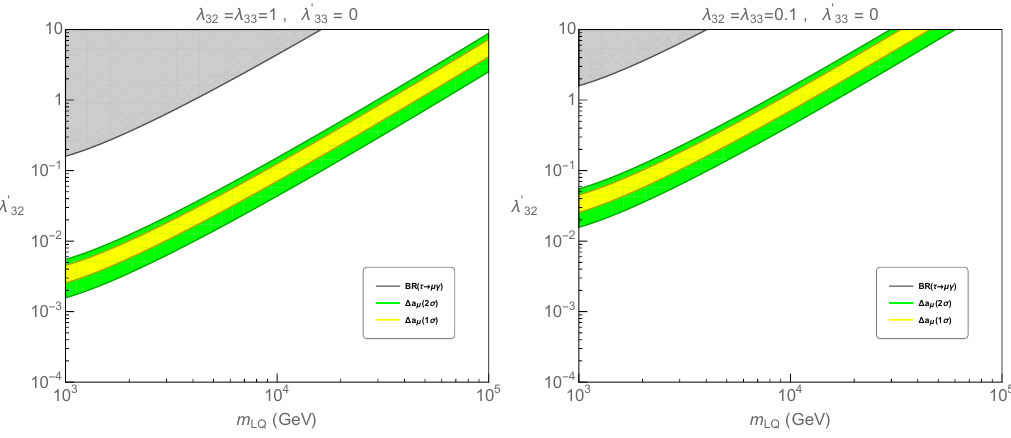
Figure 2 . Parameter space for m LQ = m S at 2 (cid:27) (1 (cid:27) ) level. The gray region is excluded by the bound on BR( (cid:28) ! (cid:22)(cid:13) ). We have (cid:12)xed (cid:21) 32 = (cid:21) 33 = 1(0 : 1) on left(right) plot and (cid:21) 0 in green(yellow) region at 2 (cid:27) (1 (cid:27) ) level. The gray region is excluded by the bound